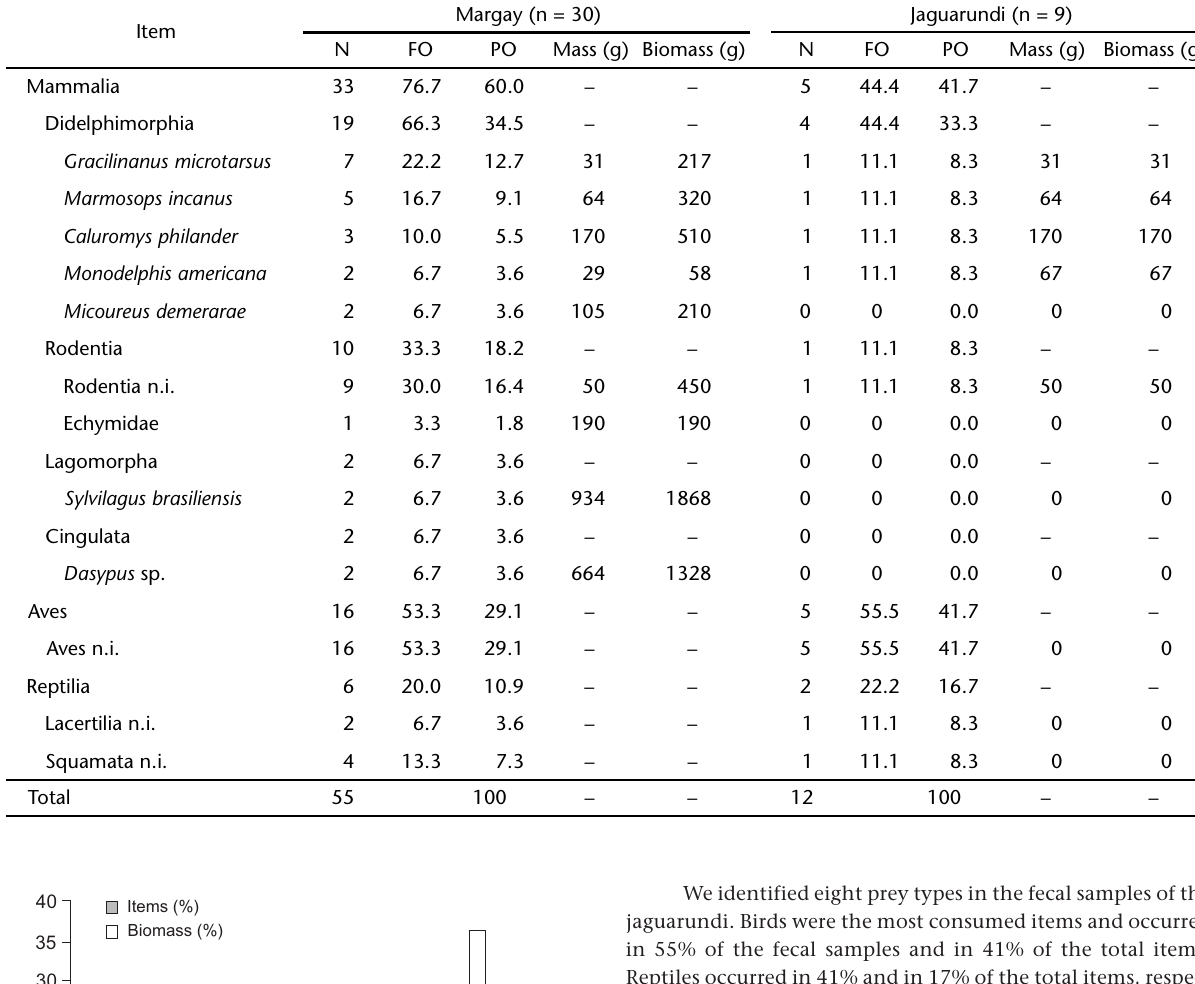
Table I. Diet items found in 30 samples of margay’s scats and nine samples of jaguarundi’s scats at Vale do Rio Doce Natural Reserve and Sooretama Biological Reserve. (N) Number of occurrence in each item, (FO) frequency of occurrence, (PO) percentage of occurrence, Mass (g) = weight, Biomass (g) = estimated biomass, (n.i.) non